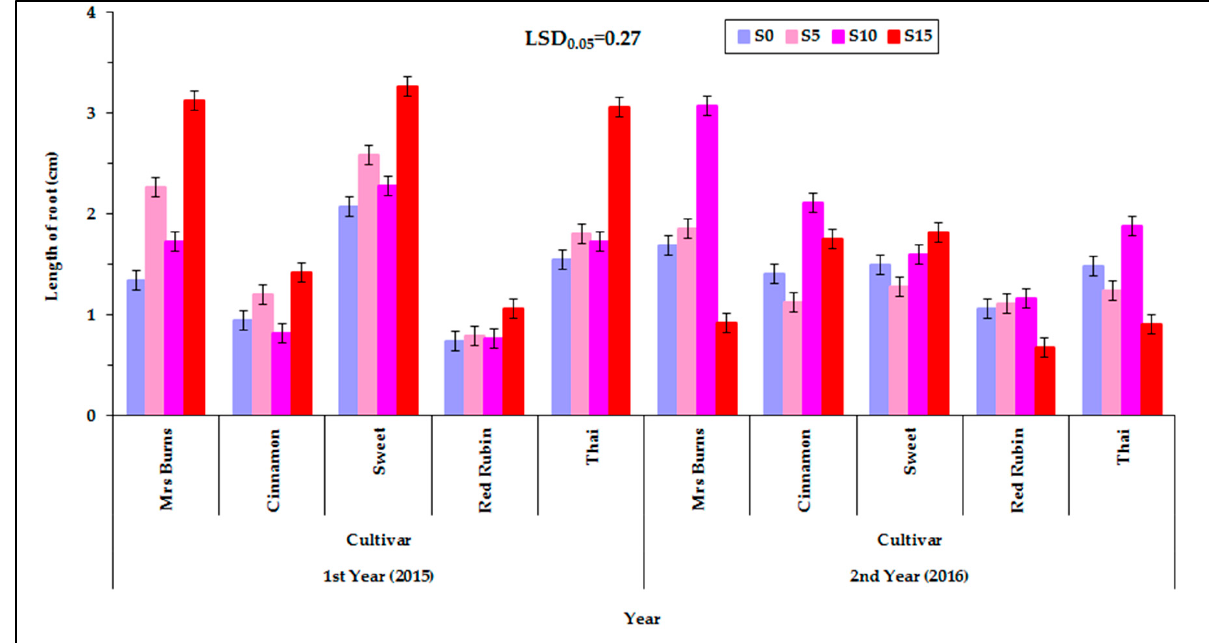
Figure 8. Root length of the five basil cultivars (“Mrs Burns”, “Cinnamon”, “Sweet”, “Red Rubin” and “Thai”), at the four PEG concentrations (S 0 , S 5 , S 10 and S 15 ), at the two years of experimentation. Data presented are estimated mean values averaged over the three irrigation levels. LSD is the least significant difference at the 0.05 significance level. Error bars correspond to the estimated common standard error of the mean values. Each mean value has been estimated utilizing n = 12 measurements. Figure S8 (see Supplementary Material) presents the observed mean values and the corresponding individual standard errors.